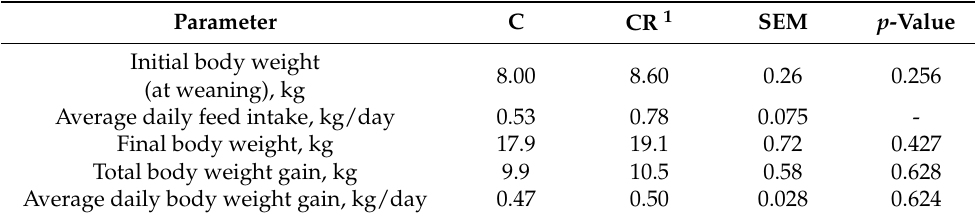
Table 3. Feed intake and growth parameters of piglets fed the control diet (C) and the diet supple- mented with 4% of dried chicory root